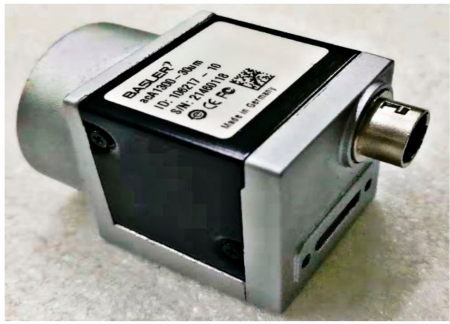
Figure 16. The acA1300-30 µ m Basler industrial